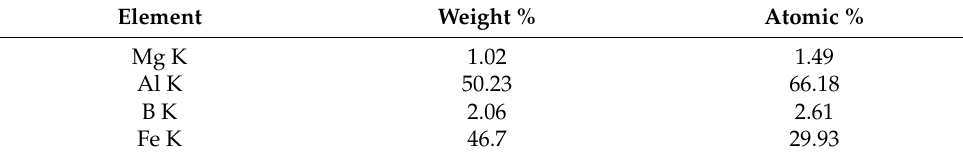
Figure 16. EDX analysis spectrum at point B in specimen welded in inert conditions. Table 12. EDX quantitative analysis data at point B in specimen welded in inert conditions.